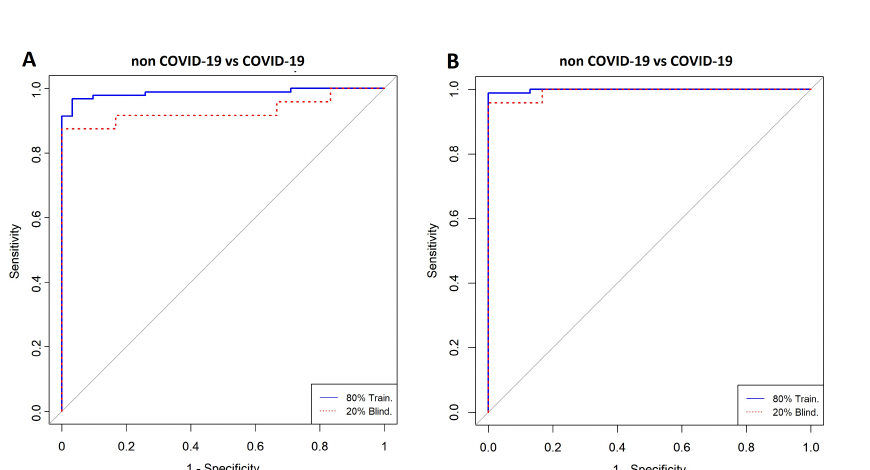
Figure A3. ROC curves for the prediction of COVID-19 ( A ) Logistic Regression ( B ) Support Vector Machine The model A was built with cough, lysoPC a 26:0, dysgeusia, anosmia, SM16.0, age. The model B was built with cough, dysgeusia, anosmia, neutrophils, chest pain, PC aa C36:6, obesity, lymphocytes, C10:1, spermidine, lysoPC aa C28:0, fever, tryptophan, platelets, lysoPC aa C26:0, IL-10, lysoPC aaC26:1, IL-6, propionic acid, IP-10, butyric